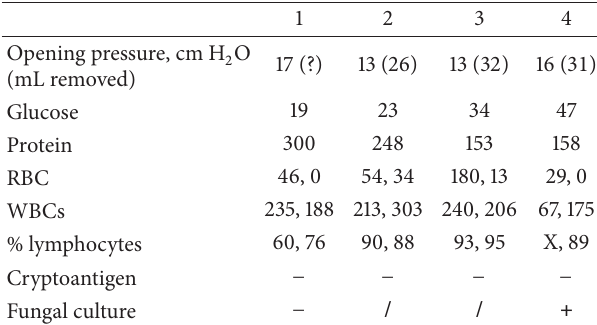
Table 1: Serial lumbar